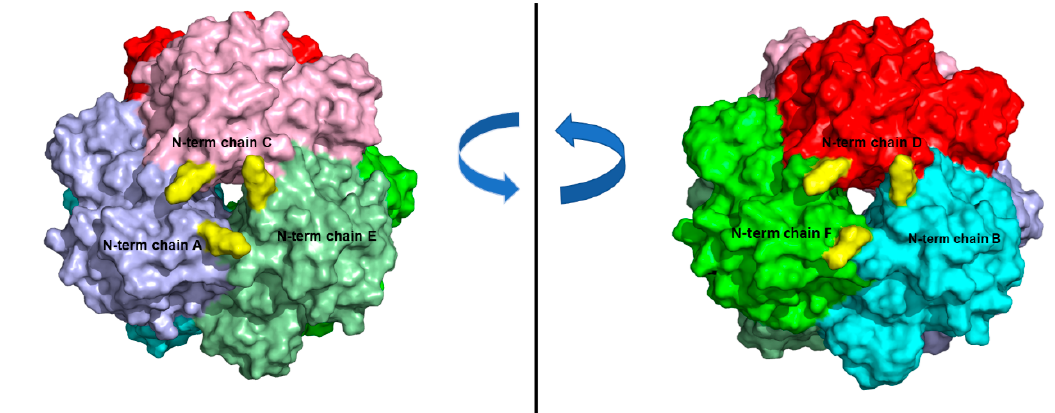
Figure 5. Surface representation of hexameric Ld NDT. The different chains (A–F) are highlighted in different colors. N-terminus residues are yellow colored.